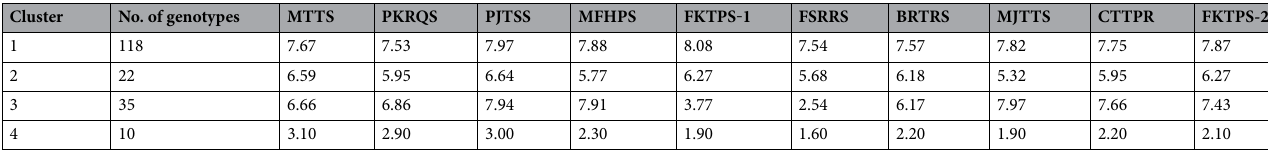
Table 2. Means of disease severity (0–9) of wheat genotypes to different P.triticina races in four